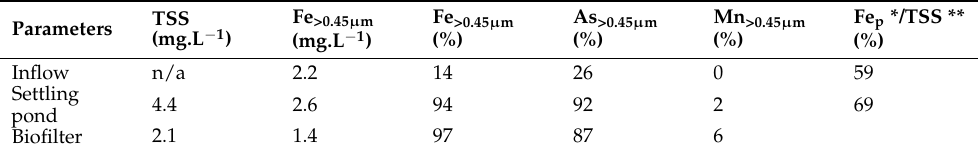
Table 3. Suspended solid concentrations and contribution (in %) of the solid phases of Fe, As, and Mn to the fluxes of elements transported in